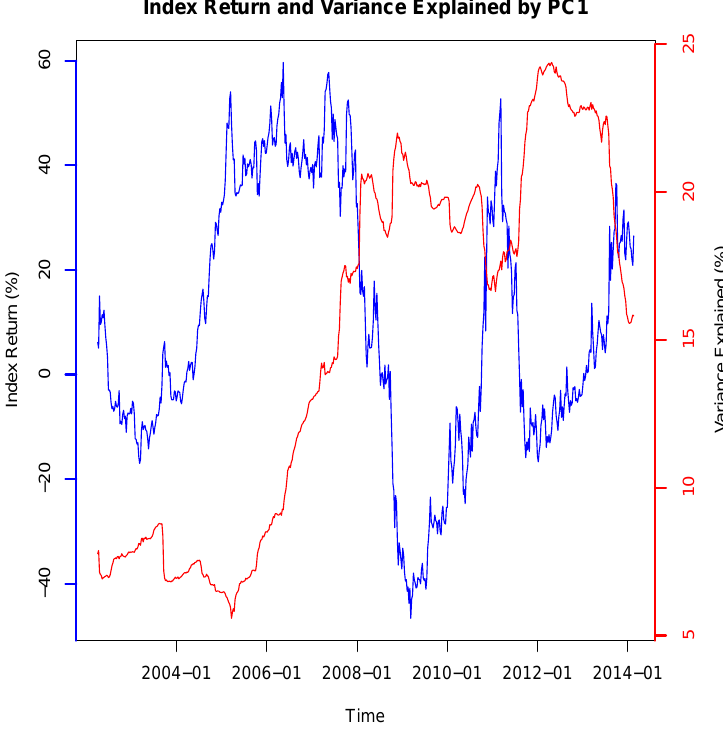
Figure 3. The variance explained by PC1 (right hand axis, red line) and the ASX200 index returns (left hand axis, blue line). Both the variance explained by PC1 and the ASX200 index returns were calculated weekly using a rolling window size of two years (equivalent to 504 trading